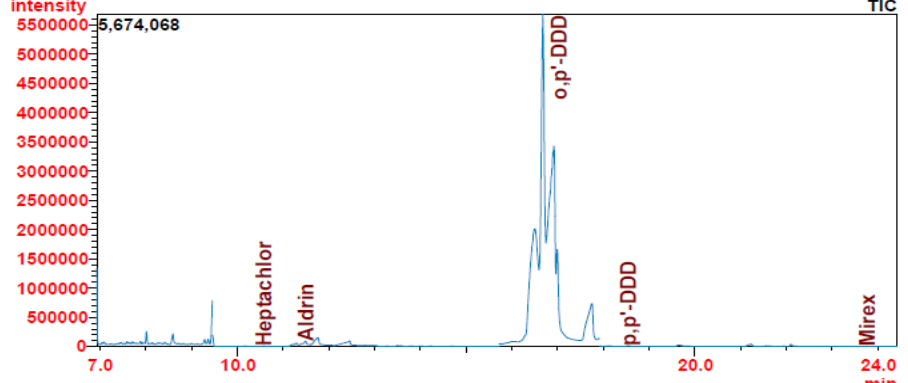
Figure 2. Chromatogram of OCPs in S. wynaadensis Jatarpalayam from River Cauvery.